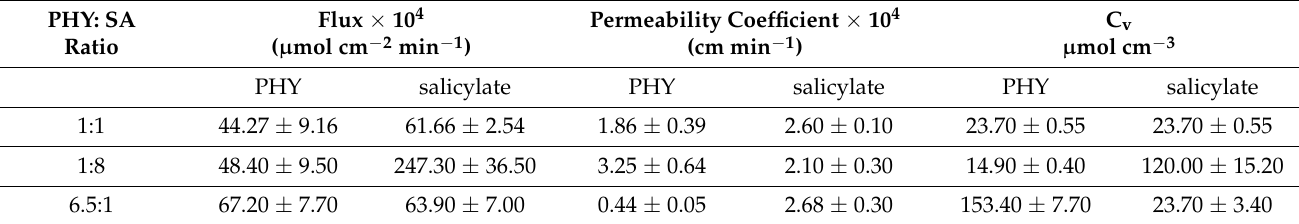
Table 17. Effect of solute composition on concentration (C v ), flux values and permeability coefficients of PHY and salicylate, when delivered through human skin ( n ≥ 3 ≤ 8, values represent the mean ± S.E.M.). Adapted from [41], Wiley, 1992. PHY: